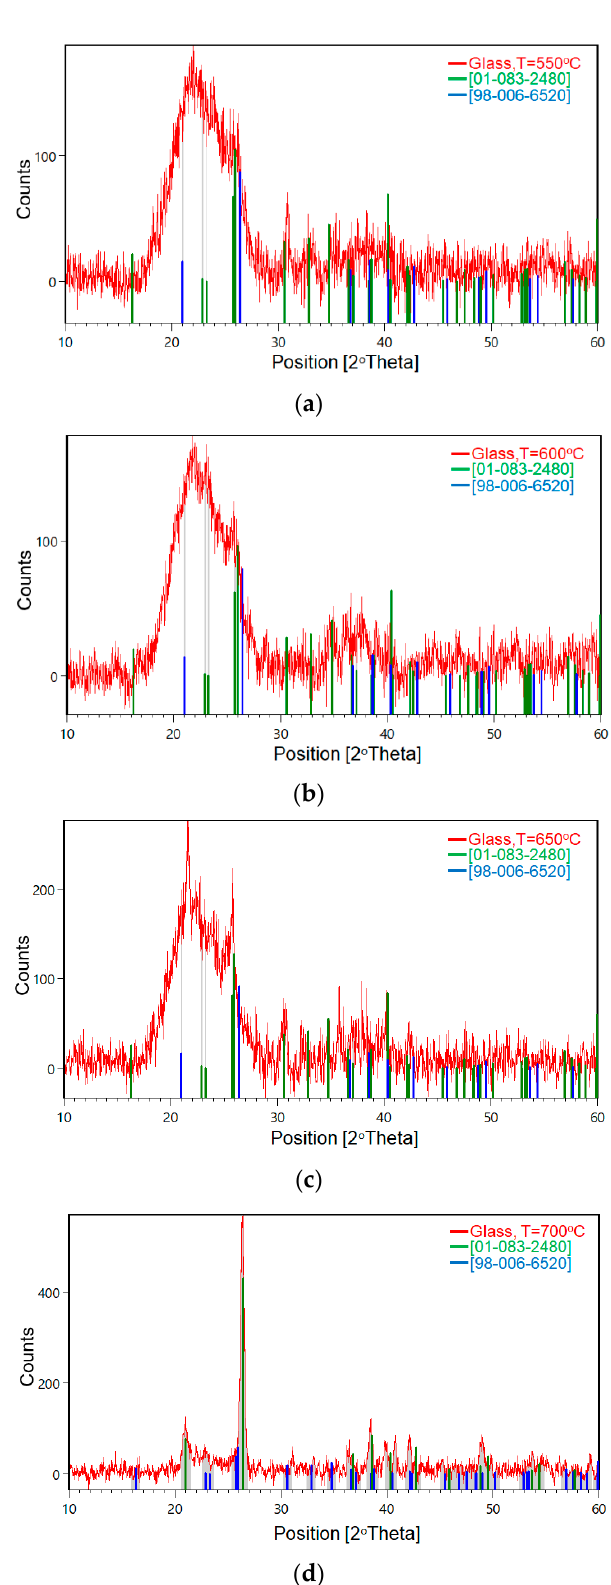
Figure 10. XRD patterns recorded at different temperature of heat-treatment ( a ) 550 °C, ( b ) 600 °C, ( c ) 650 °C, and ( d ) 700 °C, for 93GeO 2 –6Al 2 O 3 –1Bi 2 O 3 glass. ( c ) 650 ◦ C, and ( d ) 700 ◦ C, for 93GeO 2 –6Al 2 O 3 –1Bi 2 O 3